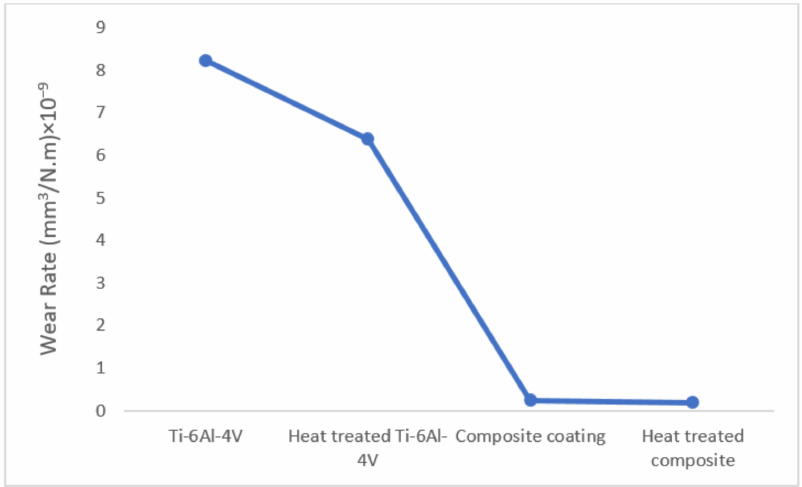
Figure 9. Specific wear